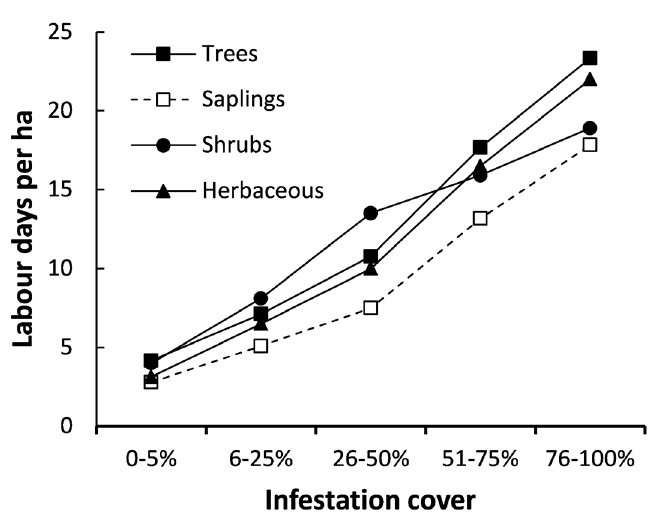
Figure 1. Work rates for control actions in relation to weed cover for different growth habits in KwaZulu Natal, South Africa. Values for each habit are averages for different control methods, calculated from data in Goodall and Naudé (1998). Maintenance control, as defined by the authors, is that undertaken at 0–5% infestation